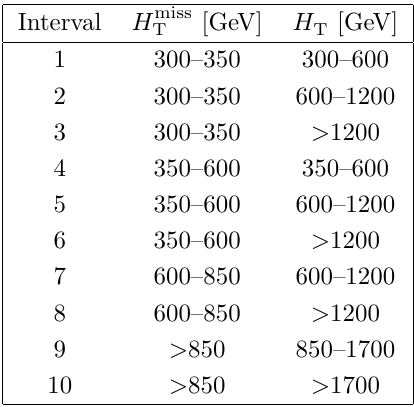
and H variables. Intervals 1 and 4 are T T > H are excluded as illustrated in (cid:12)gure T T